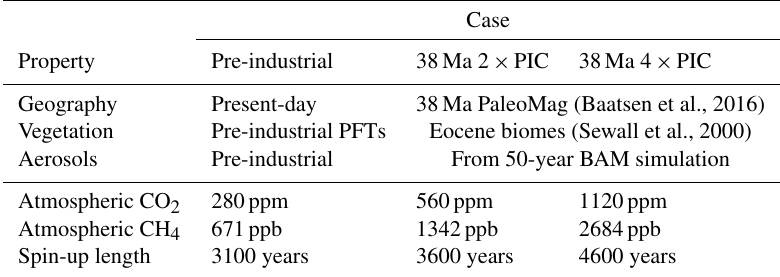
Table 1. Overview of characteristics for all CESM 1.0.5 simulations that were performed (PFT: plant functional type, BAM: bulk aerosol model).